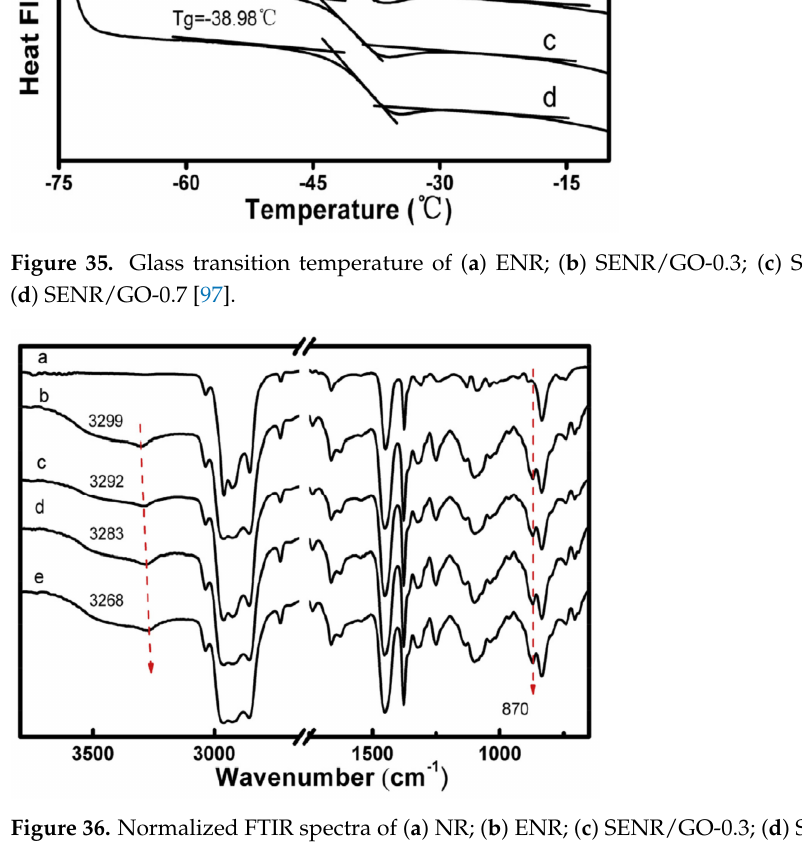
Figure 36. Normalized FTIR spectra of ( a ) NR; ( b ) ENR; ( c ) SENR/GO-0.3; ( d ) SENR/GO-0.5, and; ( e ) SENR/GO-0.7 [97].